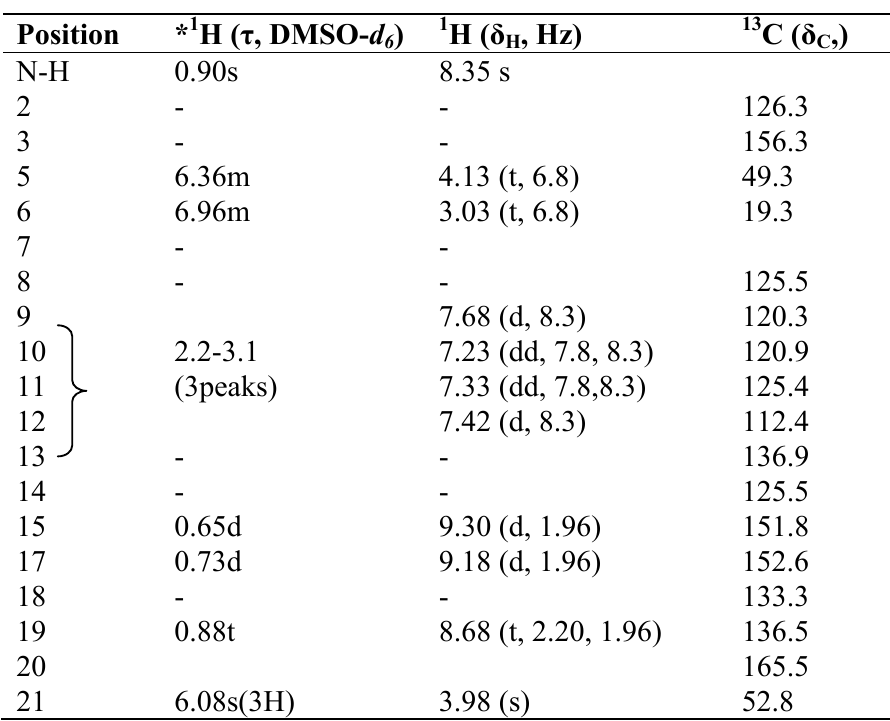
) and 13 C-NMR (100 Hz, CDCl 3